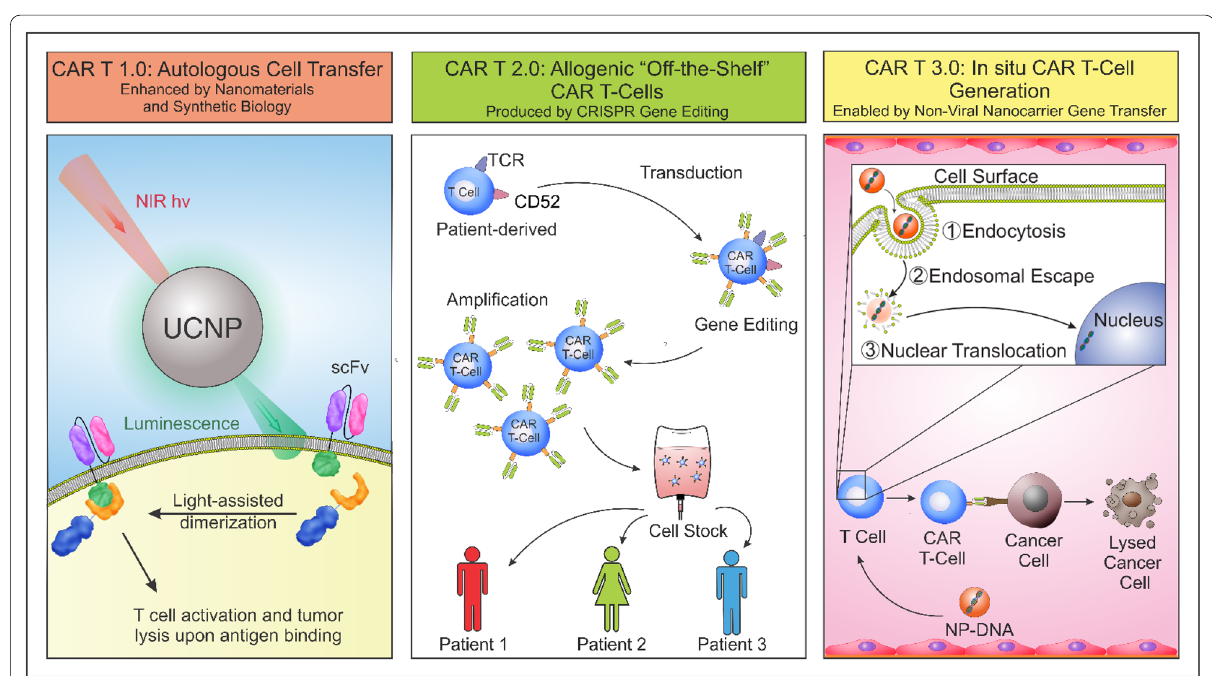
Fig. 6 Next‑generation approaches for improving CAR T‑cell therapy. Advances that combine synthetic biology and optogenetics allow the design of switchable CAR T‑cells with greater specificity and spatiotemporal control of activity to improve current autologous ACT (CAR 1.0). A step forward would be to engineer CAR T‑cells with CRISPR multiplex gene editing to inactivate or knockout genes such as TRAC and CD52 (CAR 2.0). The edited cells can then be expanded and stored as an “off‑the‑shelf” product. To decrease the time and costs associated with ACT, a potential direction is to adapt an in situ CAR T‑cell manufacturing approach to reprogram endogenous T cells into CAR T‑cells (CAR 3.0). Combined with genomic sequencing technology, this can be a personalized approach with increased efficacy and decreased overall